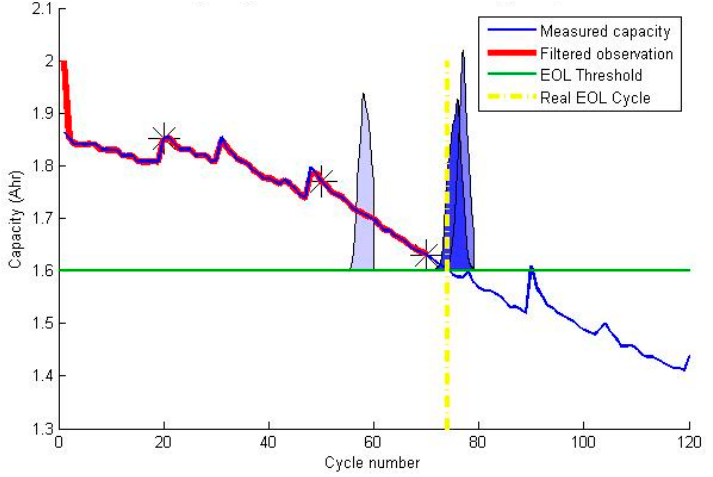
Figure 9. EOL prediction in cell B0005.